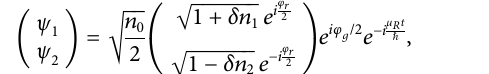
from Eq. 7 while keeping n 0 (cid:1) n 1 (0) + n 2 (0) fi